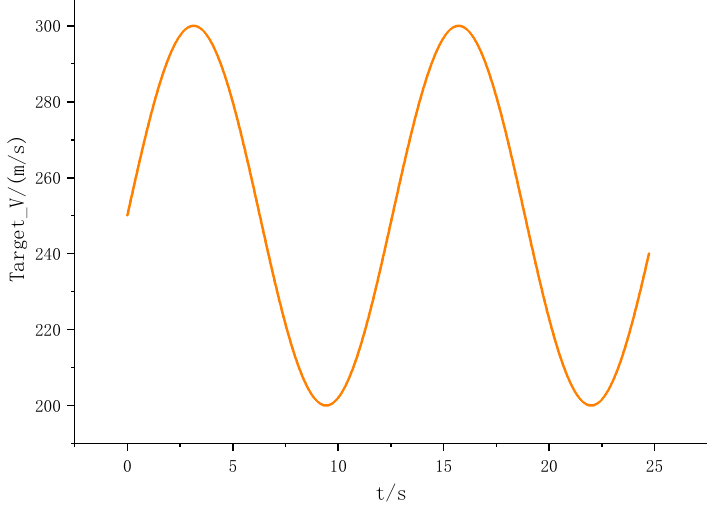
Figure 3. The maneuver characteristics of the target.